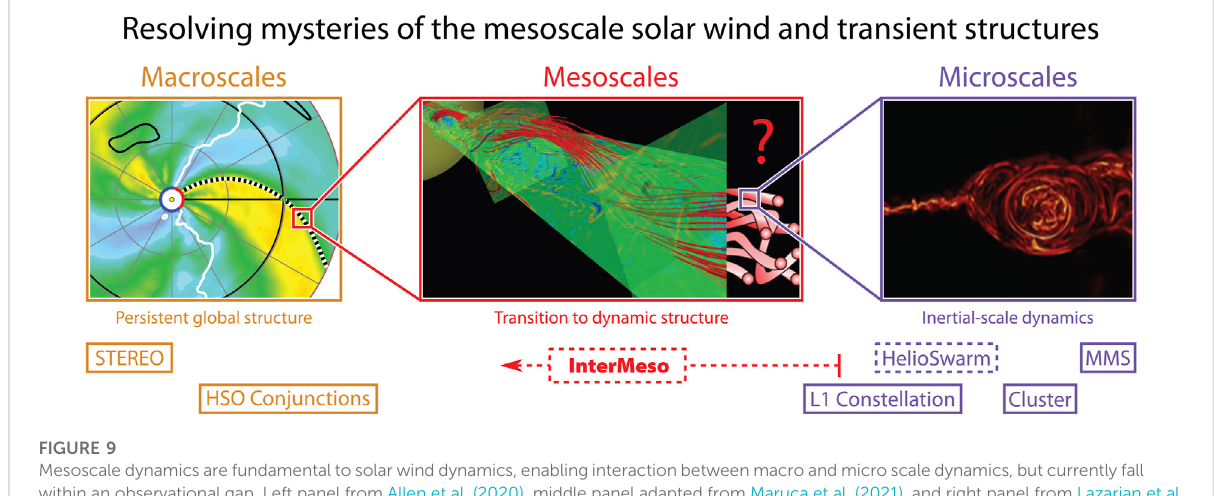
FIGURE 9 Mesoscale dynamics are fundamental to solar winddynamics,enablinginteraction between macro andmicro scale dynamics,but currently fall within an observational gap. Left panel from Allen et al. (2020), middle panel adapted from Maruca et al. (2021), and right panel from Lazarian et al. (2020). InterMeso targets fundamental knowledge gaps of solar wind dynamics and structure at these critical scale